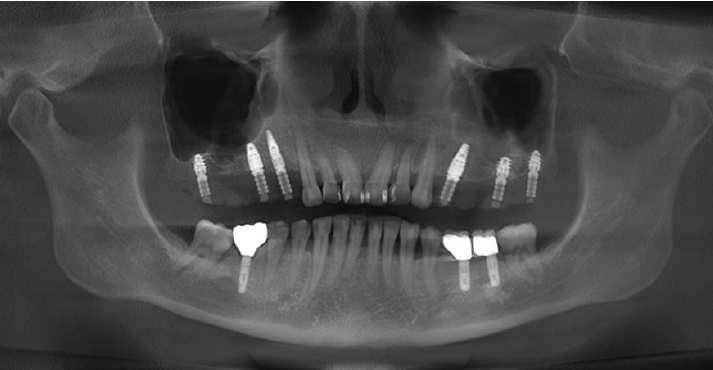
Figure 19. Panoramic radiograph of the patient in case number 2 after space closure .